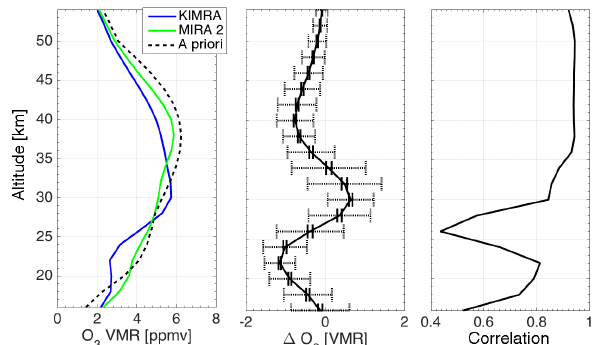
Figure 3. Left: the average of the 177 coincident O 3 profiles for KIMRA and MIRA 2 and the a priori profile used for the inver- sions. Middle: the mean of the difference (KIMRA–MIRA 2) for coincident profiles. The solid error bars are the standard error of the mean, and the dotted error bars are the standard deviation of the dif- ferences in the profiles at each altitude. Right: the correlation of the coincident pairs at each